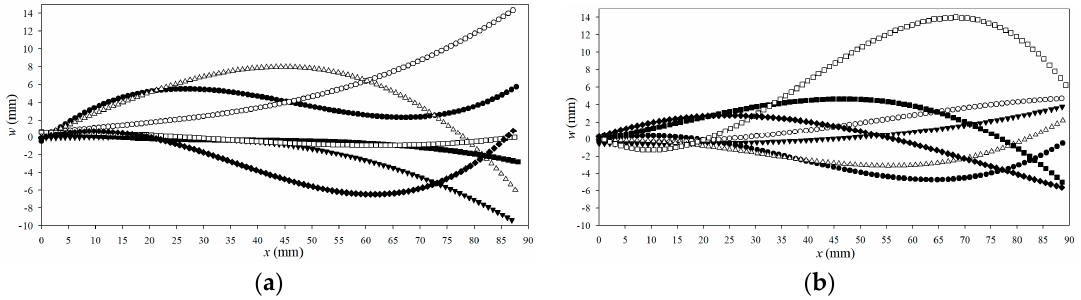
Figure 10. Characteristic deflected shapes t p = 100 µm, W = 10 mm, L = 100 mm RE = 14,279 ( a ) Water tunnel data; ( b ) FSI model results.